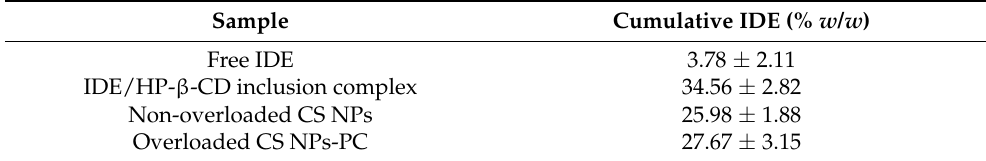
Table 5. Cumulative IDE amount (%, w / w ) detected into the excised bovine nasal mucosa after 24 h treatment with free IDE or IDE in different formulations. Results are presented as the means of six different experiments ± standard deviation.